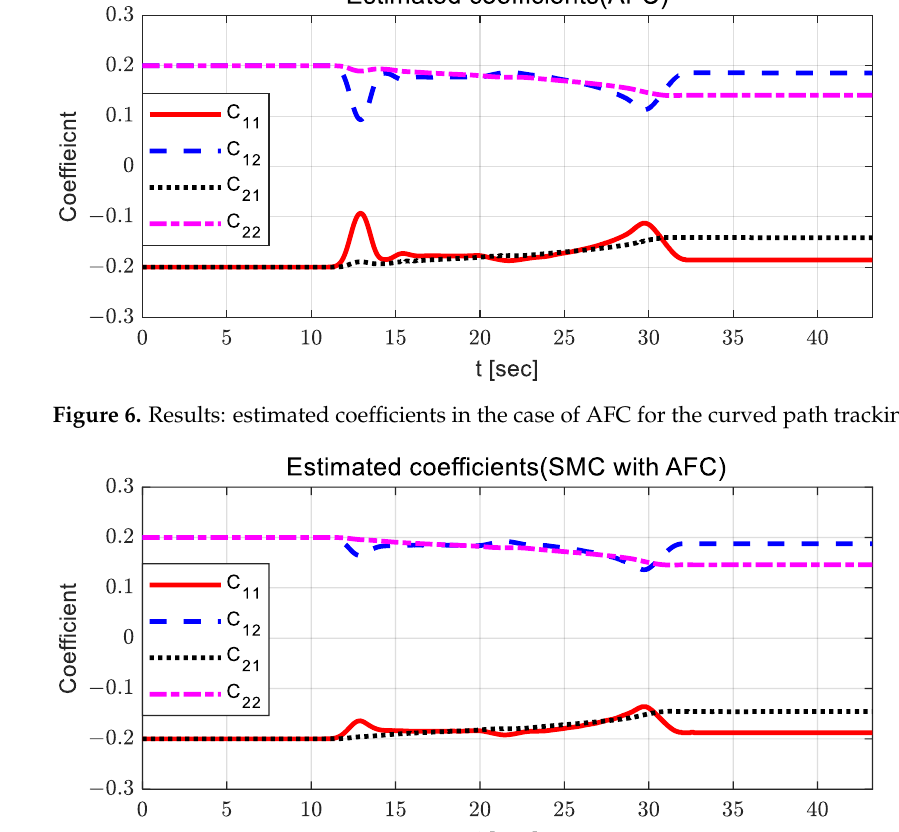
Figure 5. Results: steering control inputs for the curved path tracking.